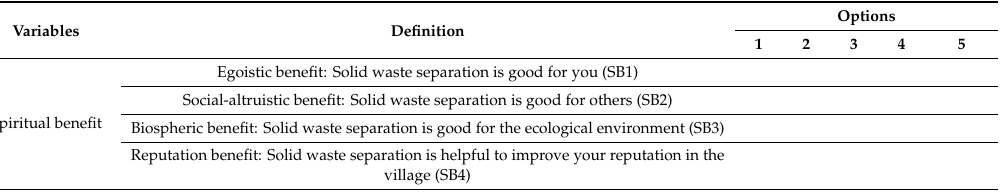
Table A3. Perceived value in the questionnaire. (Completely disagree = 1, quite disagree = 2, neutral = 3, quite agree = 4, completely agree =